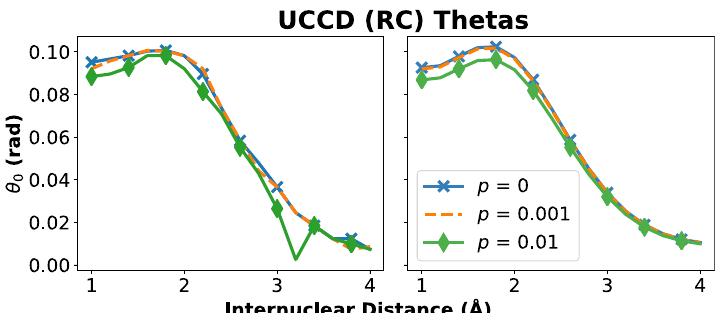
Fig. 5 The optimal paramters for the ground state enegy of the randomly compiled UCCD ansatz found using the Cobyla (left) and L-Bfgs (right) optimizers